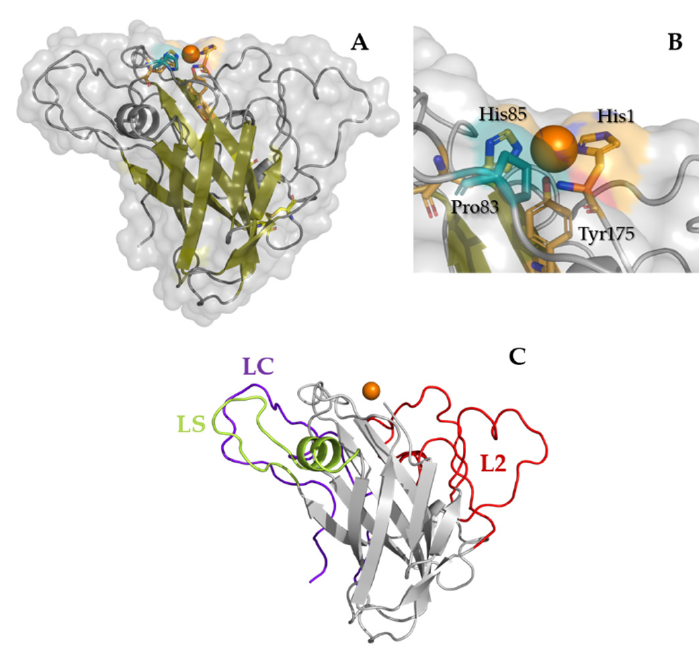
Figure 3. Homology model of TamAA9A built in SwissModel. The overall fold of TamAA9A is a conserved β -sandwich and displays a flat substrate-binding surface. ( A ) Residues coordinating the catalytic copper are displayed in bright orange, disulfide bonds in yellow and the putative residue controlling the accessibility to the copper and regioselectivity in deep teal. ( B ) Zoom of the catalytic center. ( C ) The loops interconnecting the strands that define the substrate-binding surface are: red, L2; green, LS; purple, LC.